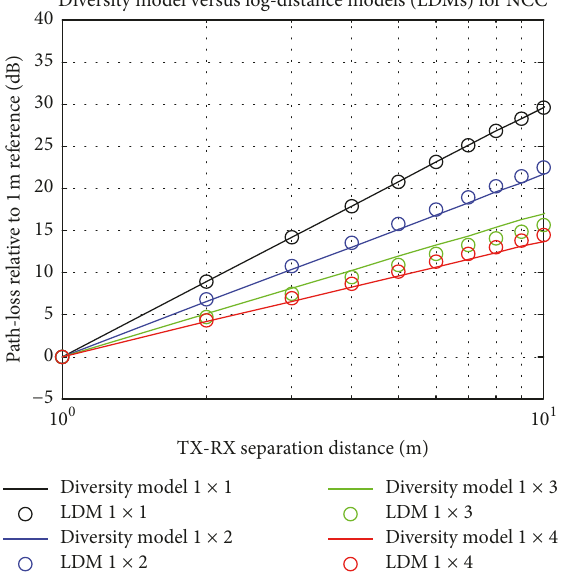
Figure 15: Path-loss for the proposed log-distance-based diversity model given by (5) for the NCC scheme when considering NLOS scenario, with 𝑛 SISO = 2.959 and 𝐴 = 0.269 .